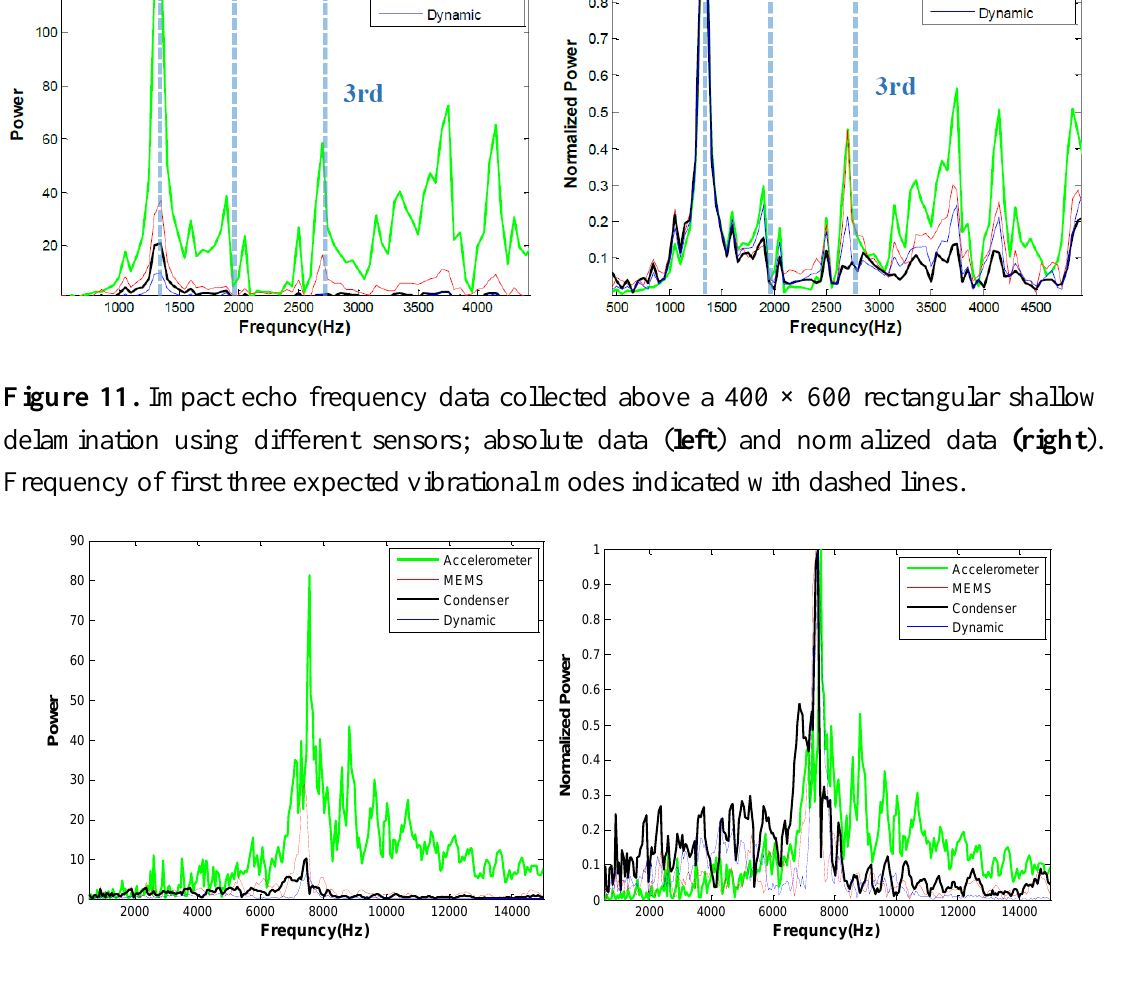
Figure 12. Impact echo frequency data collected above a solid 250 mm thick slab using different sensors; absolute data ( left ) and normalized data ( right